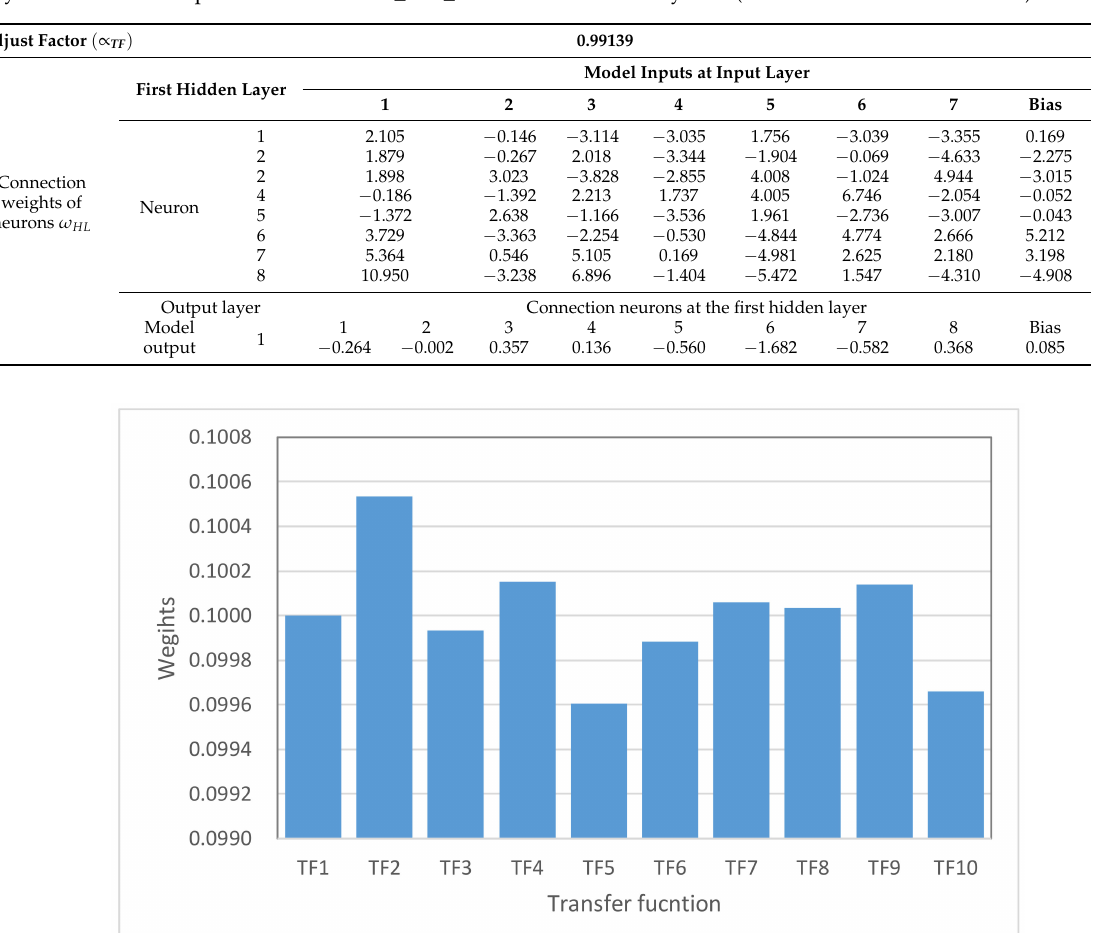
Figure 12. Summary of the weights of the transfer function for calculating the weighted average of inundation-depth